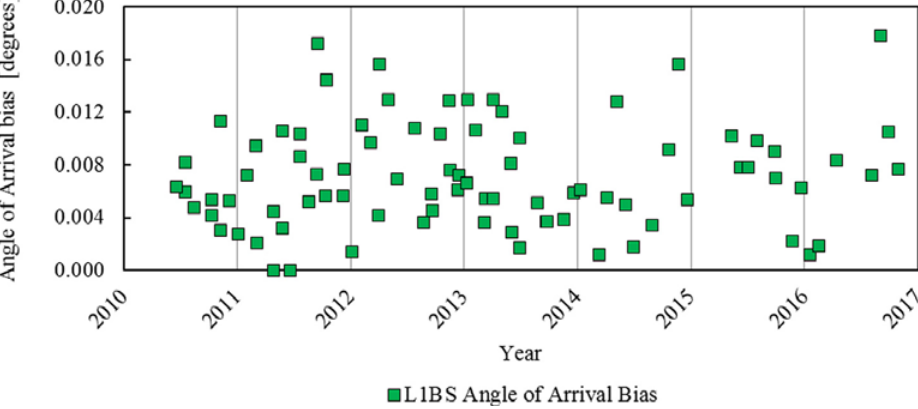
Figure 4. Angle of Arrival (AoA) calibration with transponder results. Each point represents the retrieval for a single transponder pass. Figure taken from